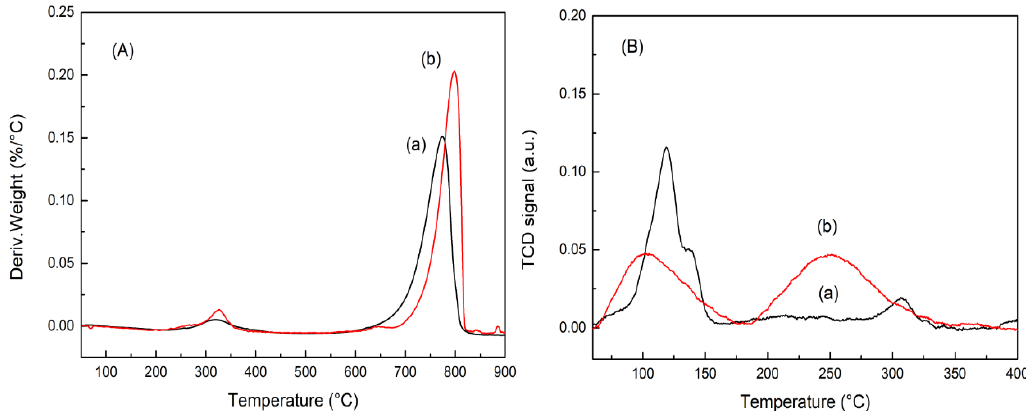
Figure 5. ( A ) Derivative thermogravimetric analysis (TGA) profiles and ( B ) Figure5. ( A )Derivativethermogravimetricanalysis(TGA)profilesand( B )CO 2 -tempurate-programmed CO 2 -tempurate-programmed desorption (TPD) patterns of ( a ) PL-12h and ( b ) HL-12h. desorption (TPD) patterns of ( a ) PL-12h and ( b )